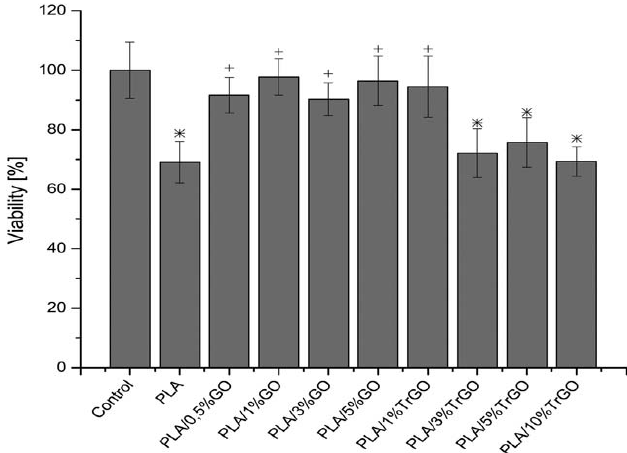
Figure 20. MTT results for PLA/GO and thermally reduced graphene oxide/polylactic acid (PLA/TRG) nanocomposites cultivated with Saos-2. * denotes statistically significance between experimental groups and control. + represents statistical significance between experimental groups and PLA ( n = 6; p < 0.05). Reproduced from [81] with permission of Wiley.